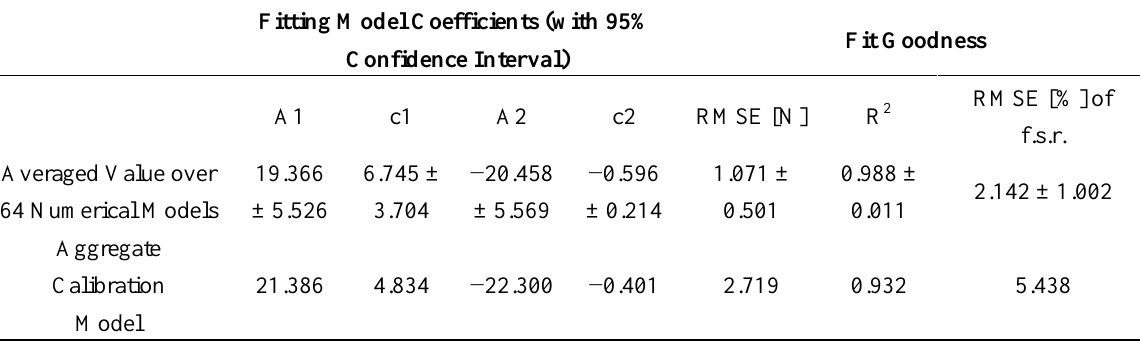
Table 1. Fitting model of the force-to-output voltage